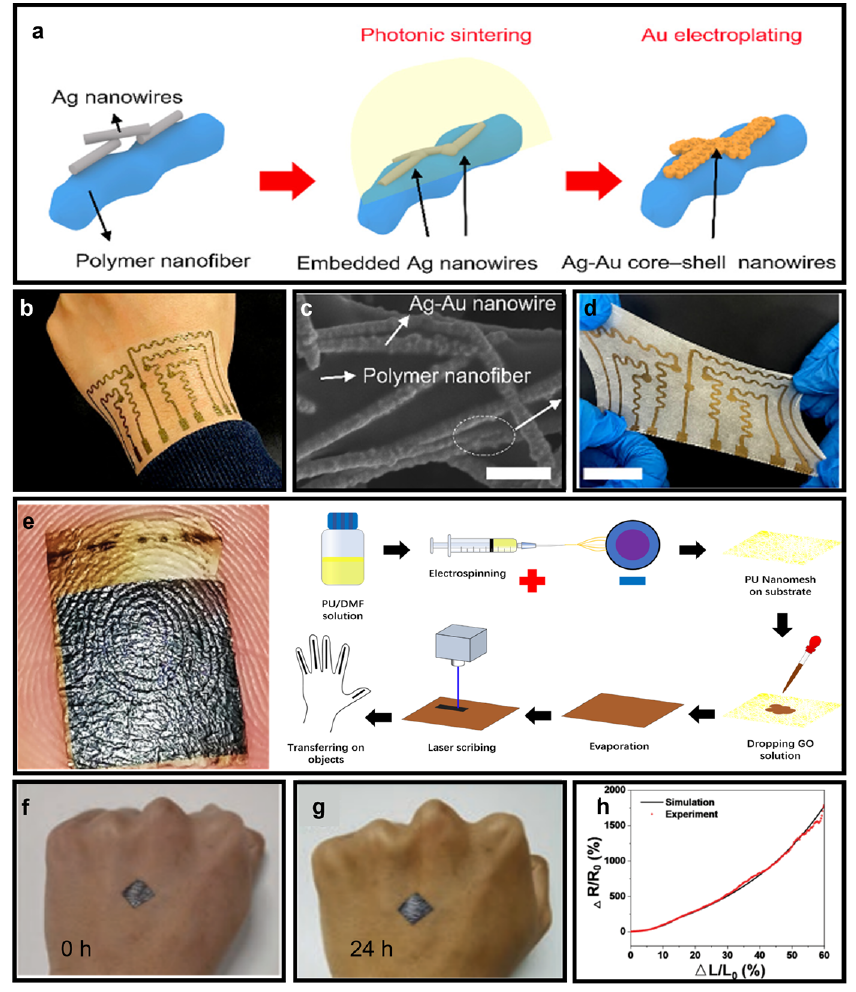
Figure 3. ( a ) Fabrication process of an Ag–Au nanowire network (AANN). ( b ) Photograph of an AANN substrate when attached to human epidermis ( c ) Microstructure of an AANN. ( d ) Stretchability of an AANN substrate. (( a – d ) Reprinted with permission from Ref. [54], Copyright 2022 Published by Elsevier Ltd.) ( e ) Photograph of LSG/PU substrate when attached to human epidermis and its fabrication process. ( f , g ) Photographs of an LSG/PU substrate attached to epidermis for different time intervals. ( h ) Tensile property of an LSG/PU substrate (( e – h ) reprinted with permission from Ref. [55], Copyright 2021 Wiley-VCH GmbH.).